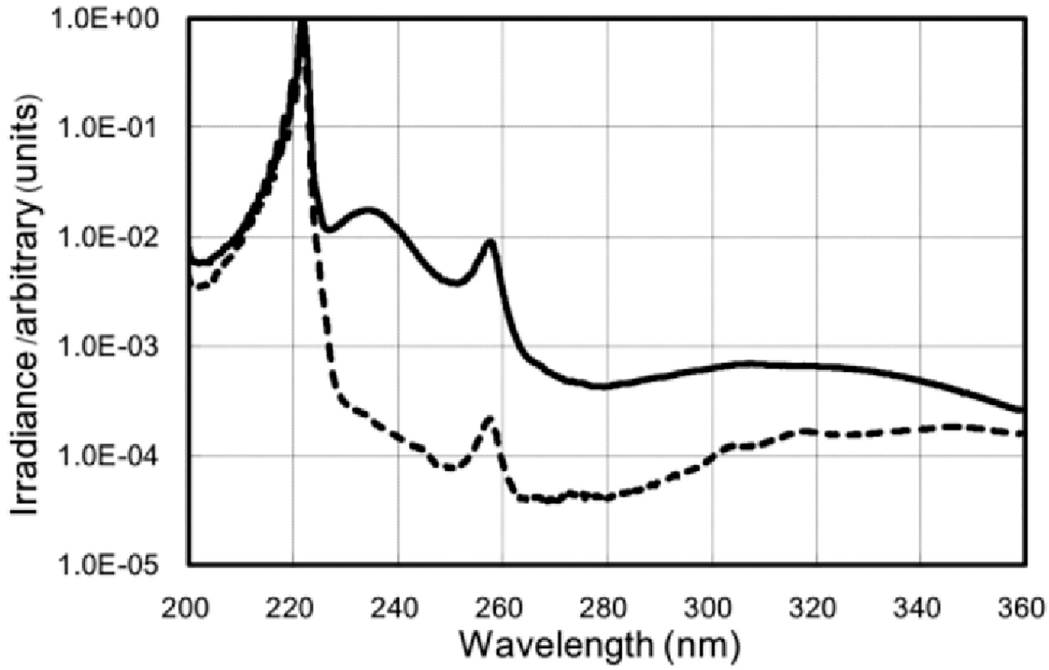
Fig 1. Measured spectra emitted from the KrCl excimer lamp equipped with a bandpass filter or without a bandpass filter. Solid line indicates the semi-logarithmic spectral irradiance of a KrCl lamp without a band pass filter normalized to the 222 nm peak. Dashed line indicates the semi-logarithmic normalized spectral irradiance of the KrCl lamp with a band pass filter that reduces the intensity outside of the 222 nm peak. Devices to measure spectra were described in Materials and Methods section. KrCl: krypton